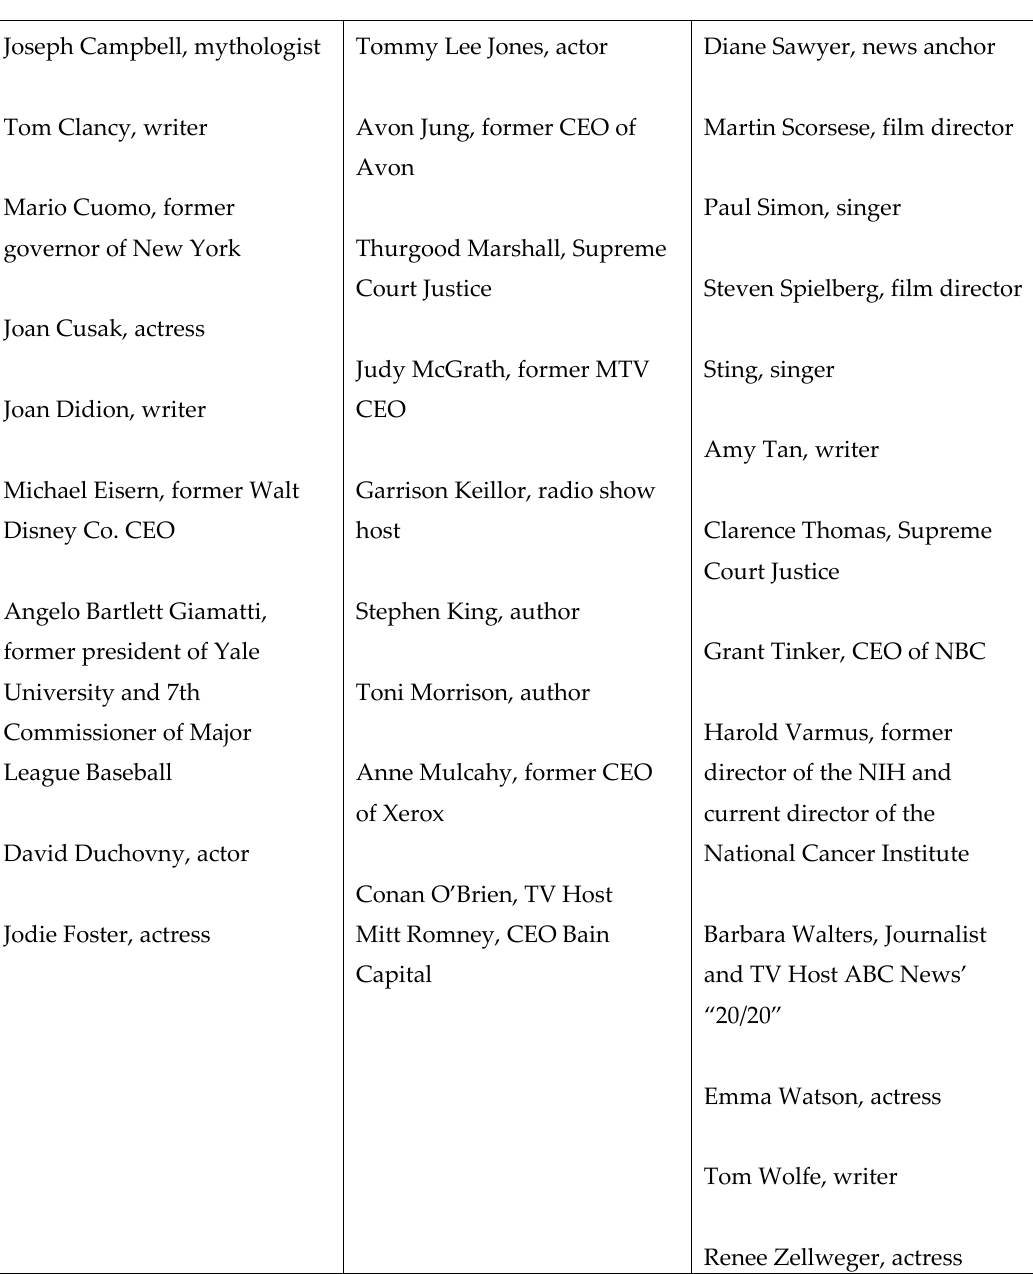
Table 1. Famous English Majors.